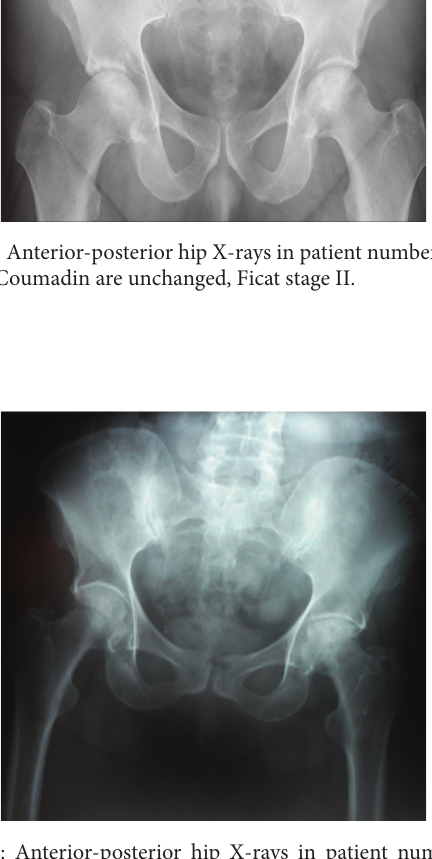
Figure 3: Anterior-posterior hip X-rays in patient number 4 at preanticoagulation study entry. The right hip is Ficat stage II and the left hip is Ficat stage III.